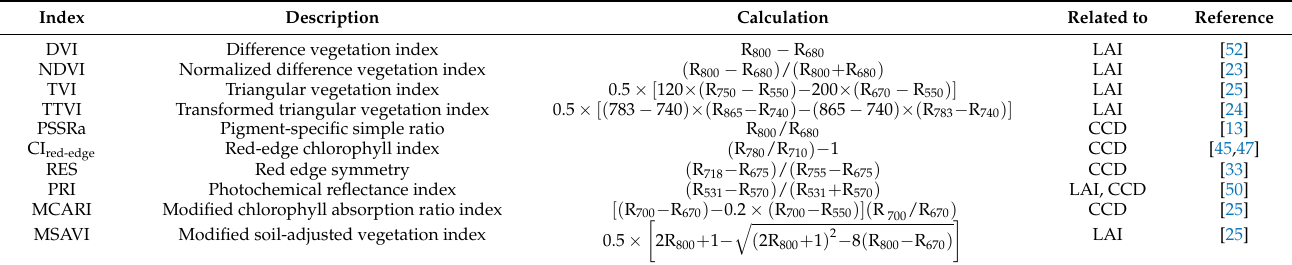
Table 3. List of vegetation indices used in the study. All the indices were calculated with hyperspectral resolution data in this